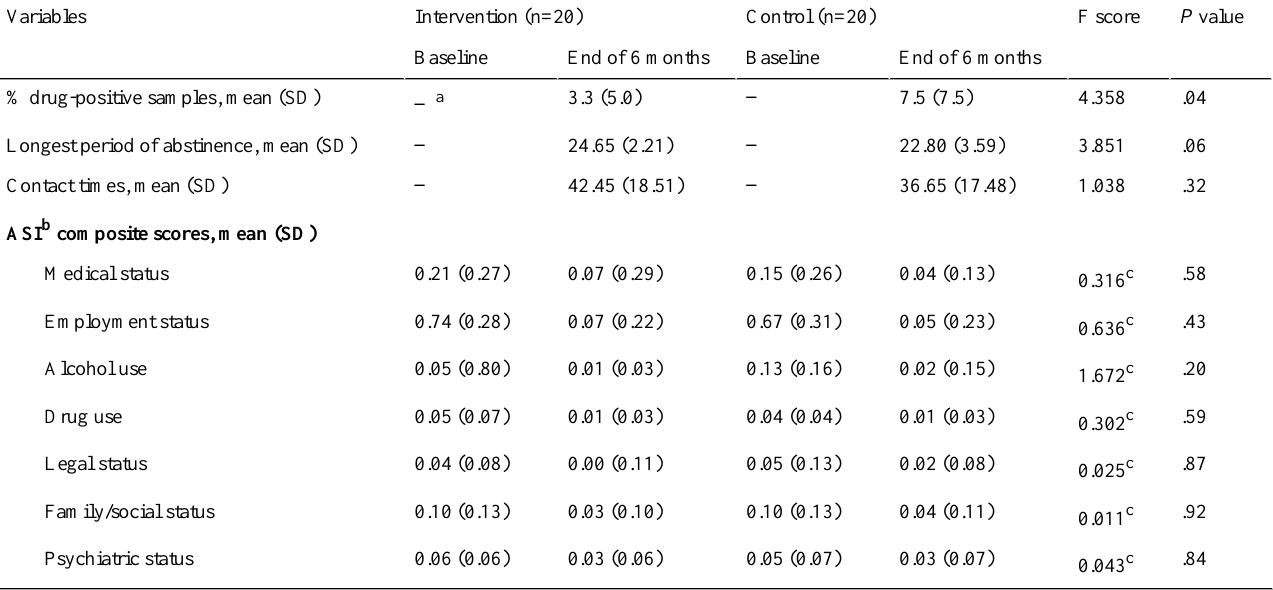
Table 3. Effectiveness of outcomes: drug use and contact